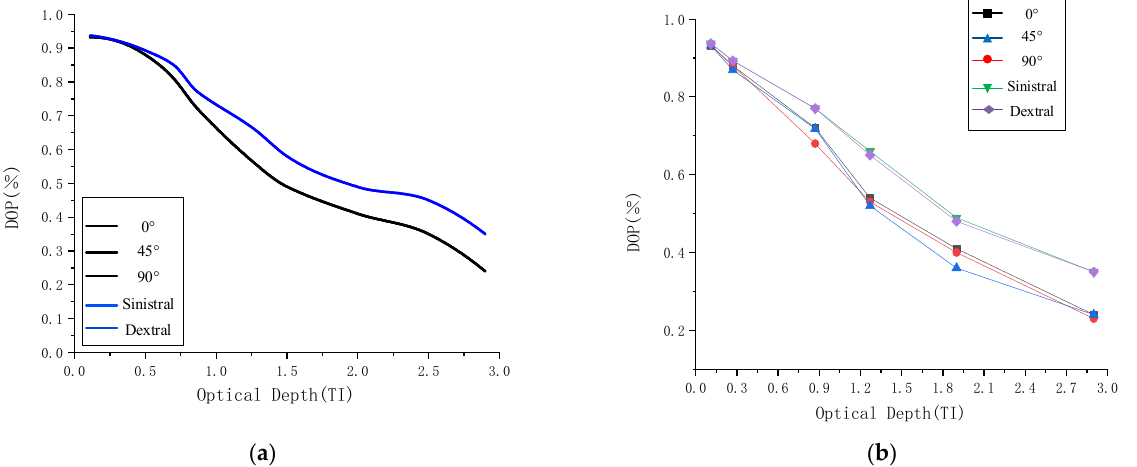
Figure 8. λ = Simulation and experimental comparison of DOP change of 450 nm polarized light: ( a ) simulation results and ( b ) experimental results.